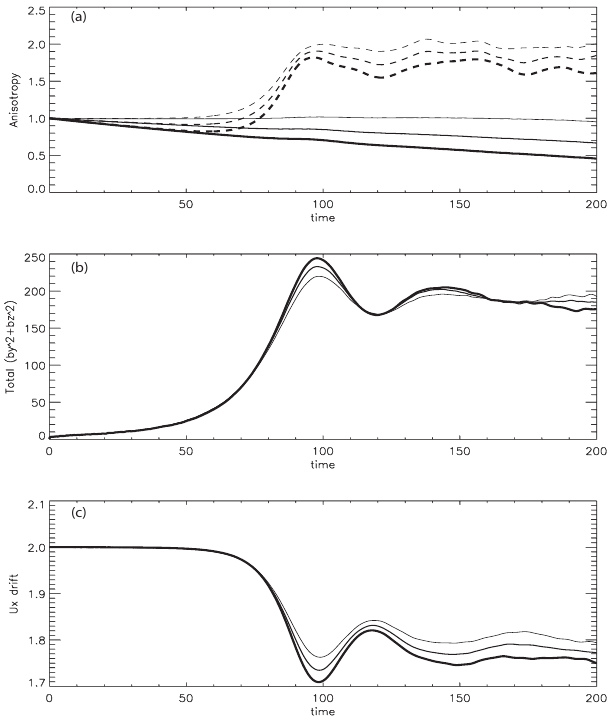
Fig. 5. The temporal evolution of the temperature anisotropy for protons (solid) and He ++ ions (dashes) obtained with the 1-D ex- panding box hybrid model for an initially drifting p-He ++ popula- tion with U x , drift = 2 (in units of the Alfv´en speed). (a) The temper- ature anisotropies. (b) The magnetic fluctuations (arbitrary units). (c) The p-He ++ drift velocity. The thin curves show the tempo- ral evolution without expansion ( (cid:15) = 0), the thicker curves are for (cid:15) = 10 − 3 , and the thick curves are for (cid:15) = 2 × 10 − 3 . The time is in units of (cid:127) − 1 p